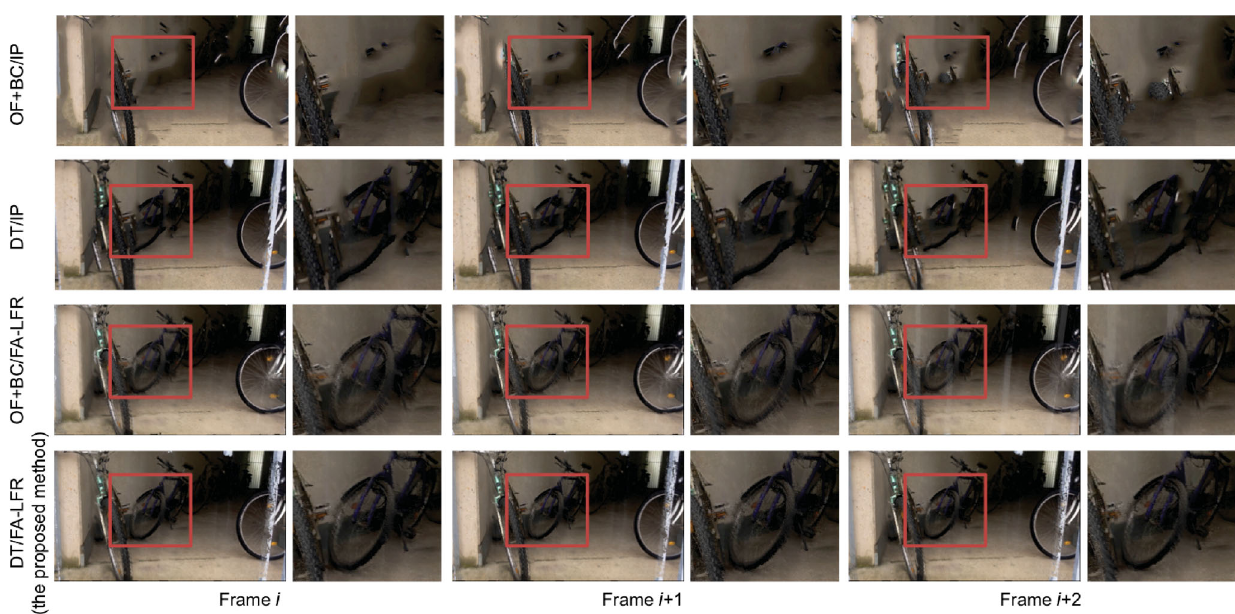
Fig. 14 Comparison of background restoration for consecutive frames of Scene 7.